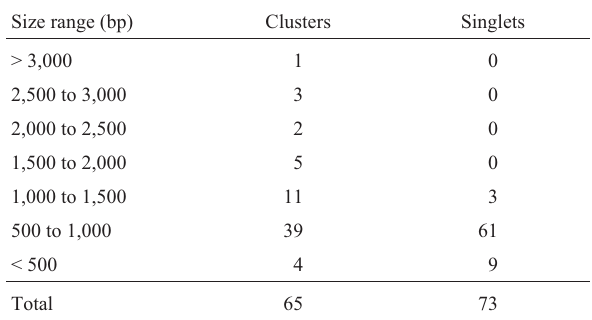
Table 4 - Size and number of clusters and singlets from partial in silico shot-gun assembly of the Citrus plastid genome, from EST and genomic sequences with high similarity to other plastomes.